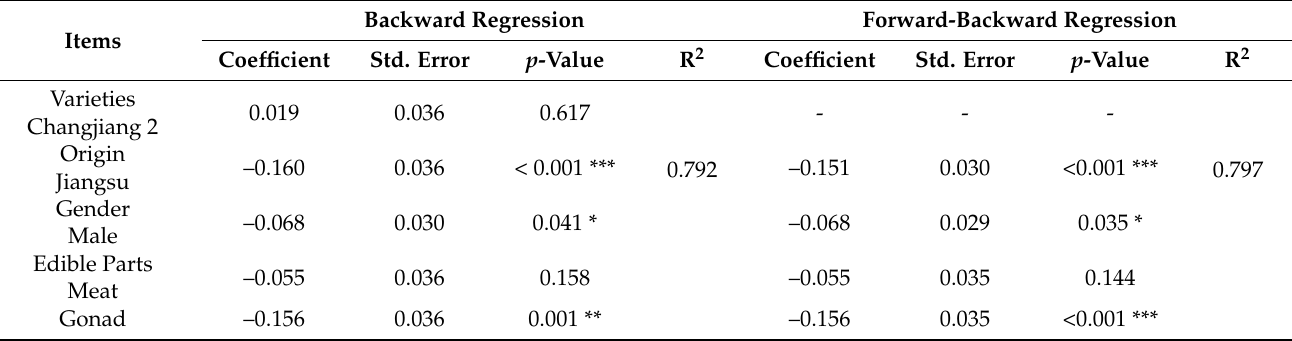
Table 4. Stepwise multivariable regression analysis for the overall consumer preference for E. sinensis from different